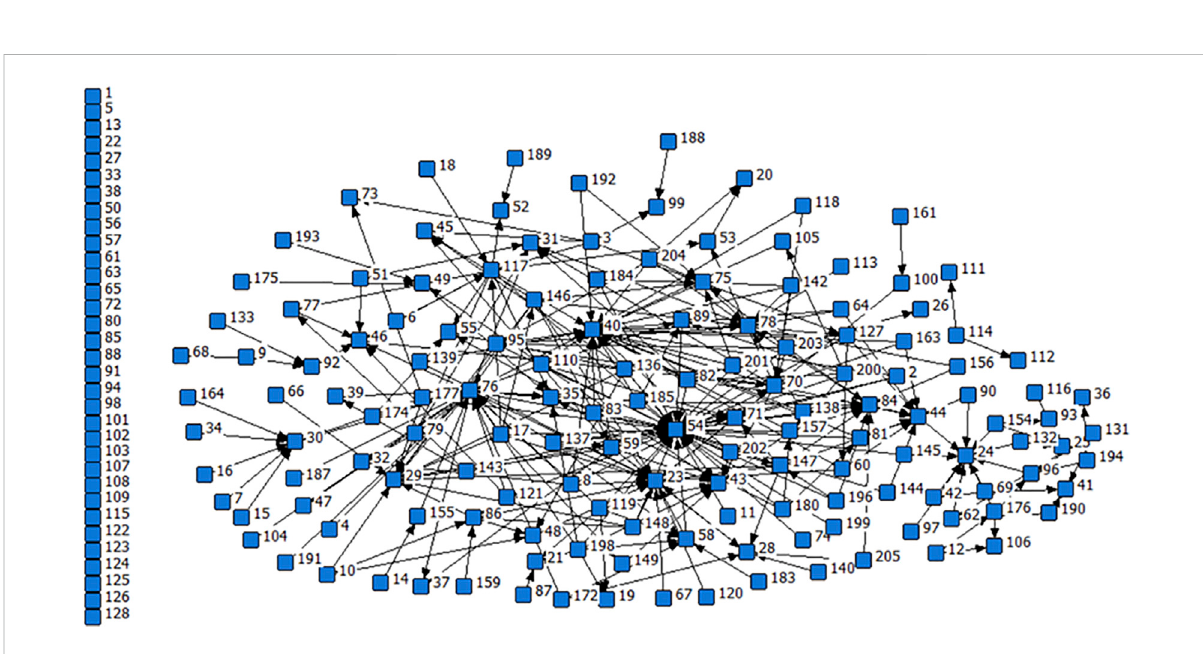
FIGURE 6 Citation network of the 205